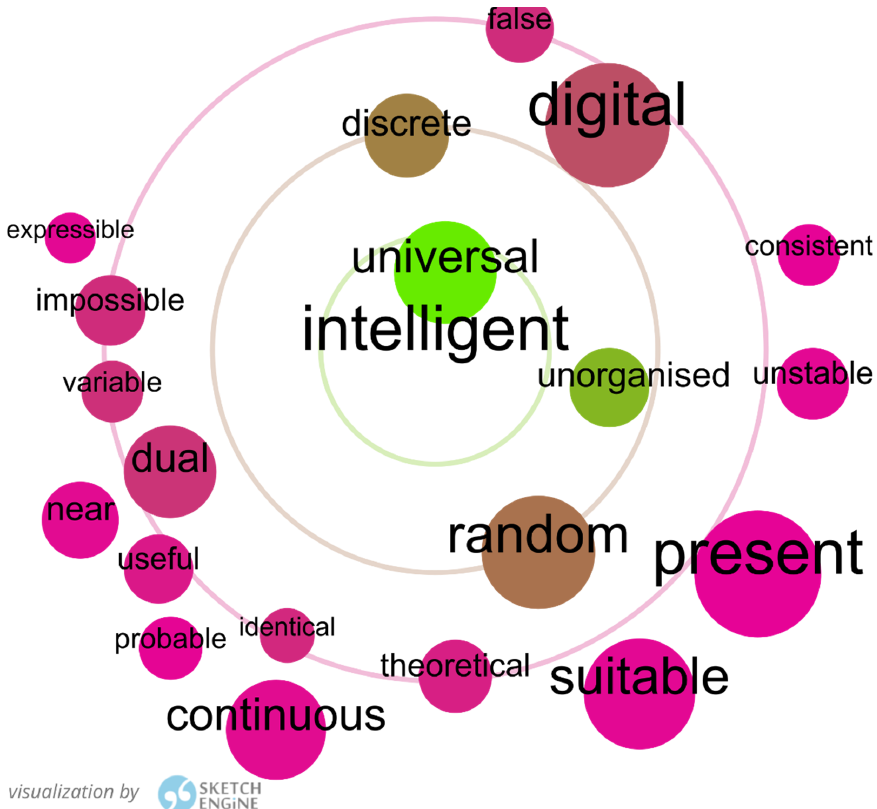
Figure 2. The visualization of terms semantically similar to “intelligent” in Turing’s writings.